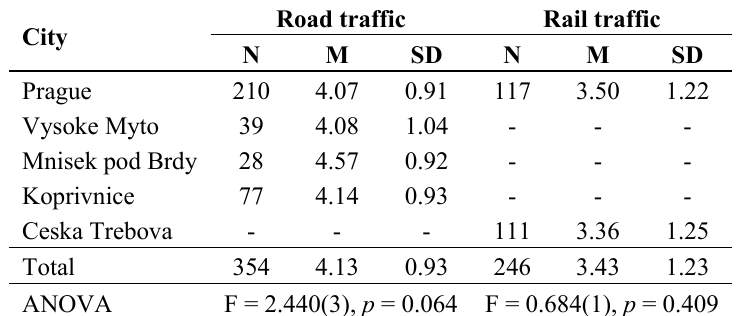
Table 2. Average noise annoyance scores in sub-samples from different cities (means, standard deviations and ANOVA test of